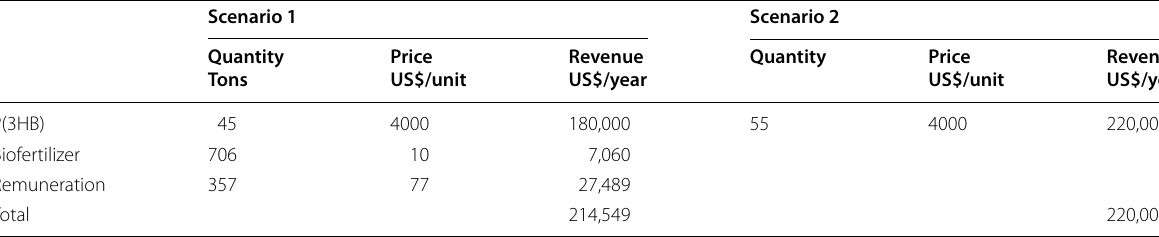
Table 4 Total annual revenue generated under Scenario 1 and 2